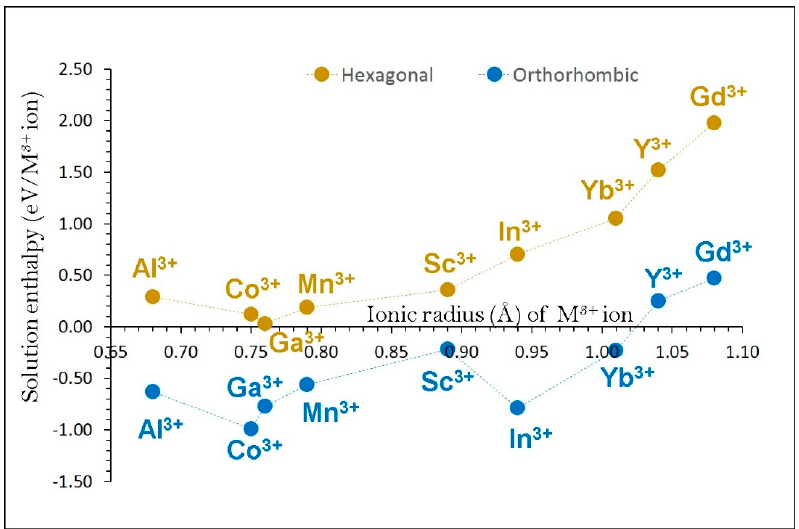
Figure 7. Enthalpy of solution of M 2 O 3 (M = Al, Co, Ga, Mn, Sc, In, Yb, Y and Gd) with respect to the M 3+ ionic radius in NaFeO 2 .